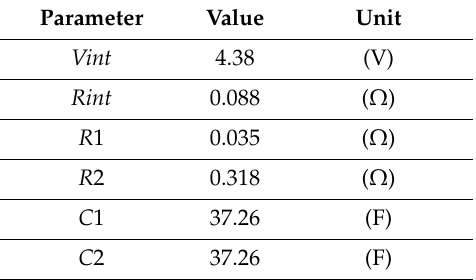
Table 3. Values of the components of the equivalent circuit model of the PEM-EL (referred to figure 6) [30].